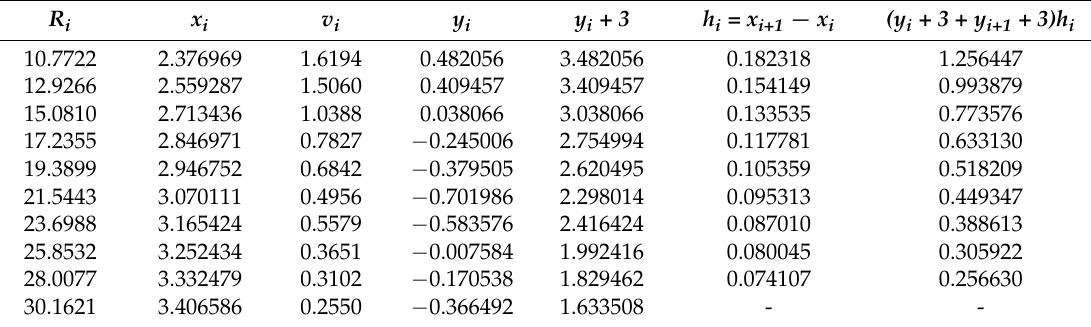
Table 2. Representation of data for calculating the parameters in Majdanpek open pit according to Model